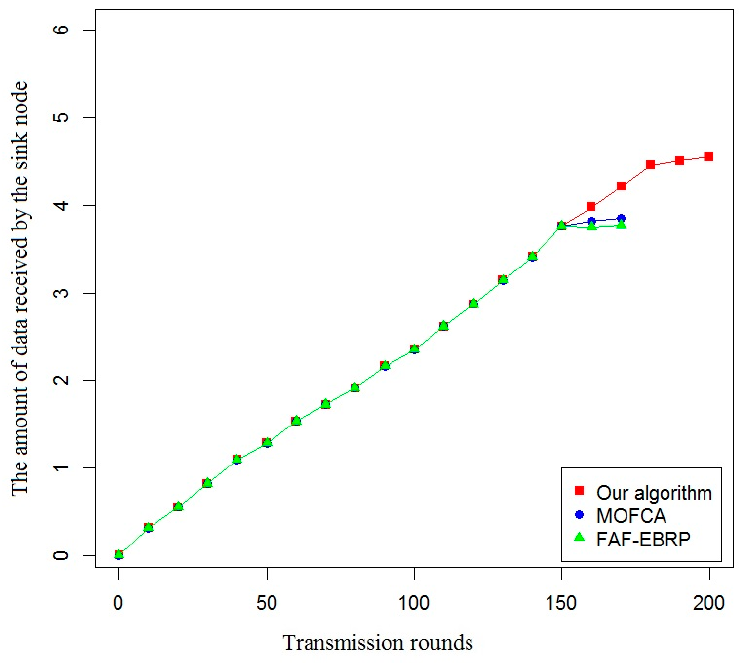
Figure 10. Comparison of the amount of data received by the sink node.